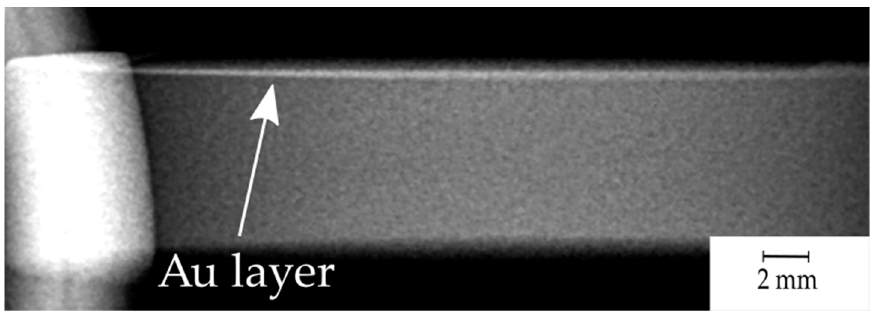
Figure 6. X-ray image (side view) of the sample with the revealed gold layer (top).